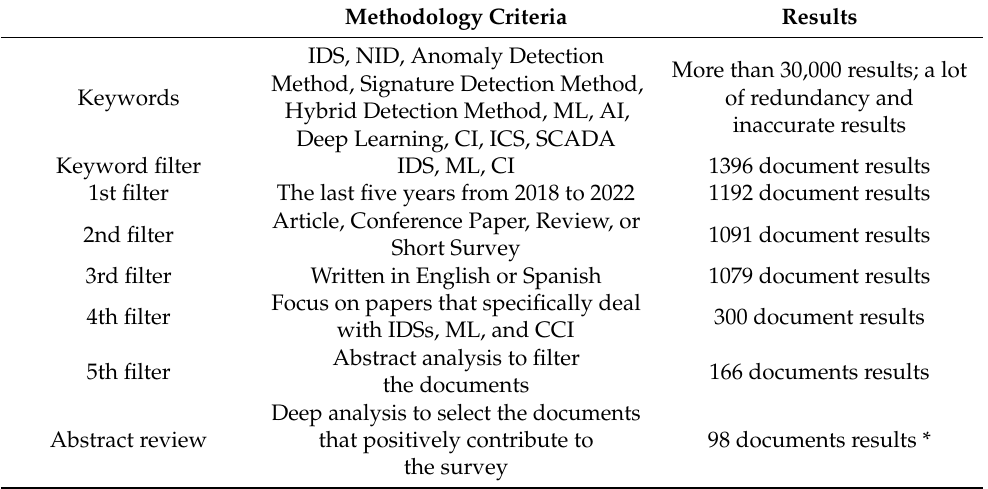
Table 2. Methodology to filter the